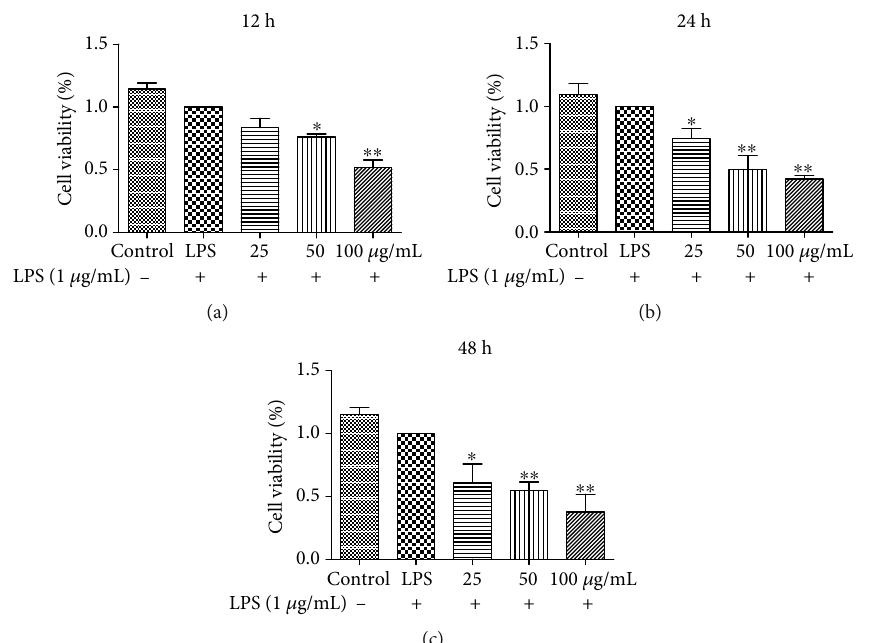
Figure 1: EECP decreased cell viability in MDA-MB-231 cells stimulated with lipopolysaccharide (LPS). (a) – (c) E ff ect of EECP on the cell viability of MDA-MB-231 cells stimulated with LPS at 12, 24, and 48h, respectively. 25, 50, and 100 μ g/mL: cells treated with EECP at 25, 50, and 100 μ g/mL, respectively. Values represent the mean ± SEM from three independent experiments ( ∗ P < 0 : 05 , ∗∗ P < 0 : 01 vs. control, n = 3